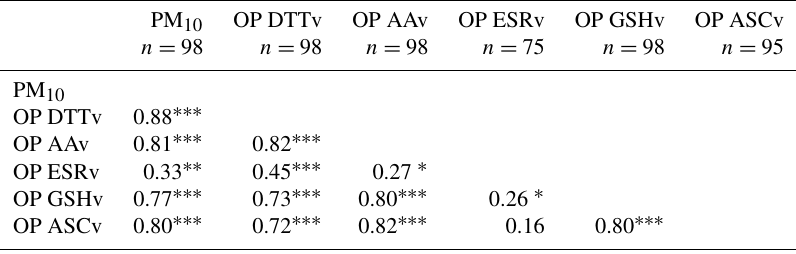
Table 2. Spearman correlation of the five OPv measurement assays over the sampling year.